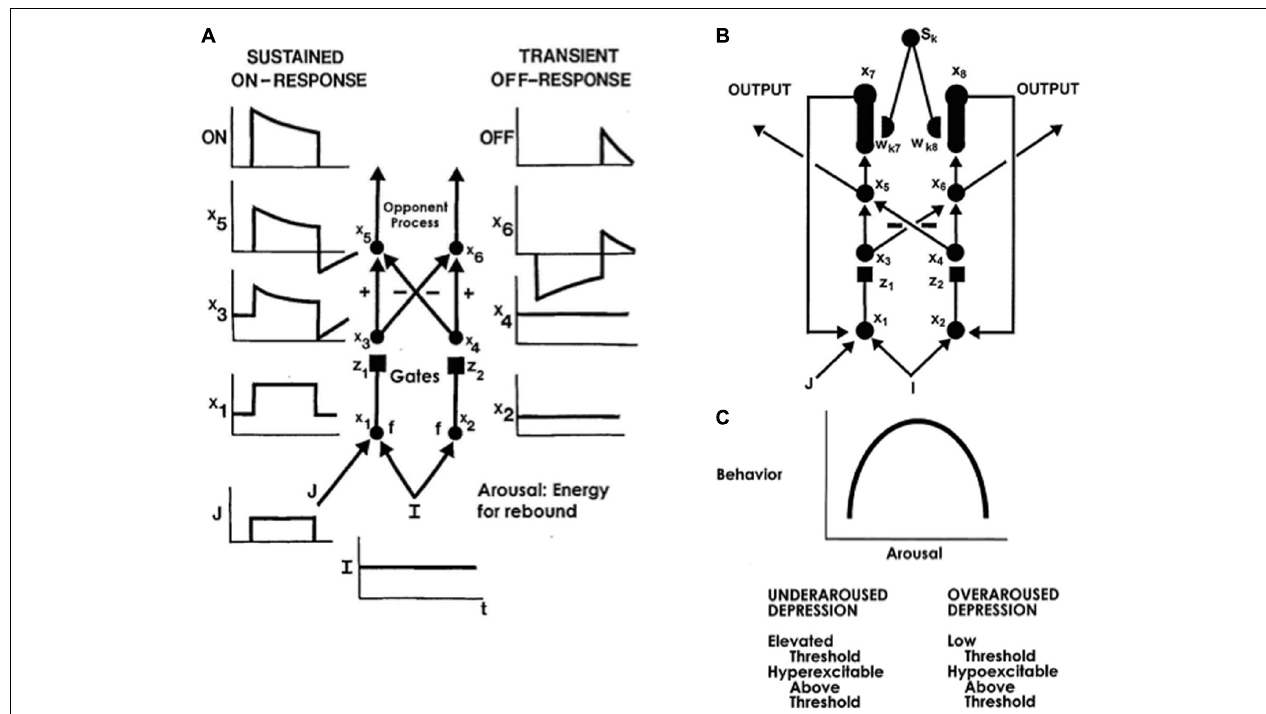
FIGURE 11 | (A) A gated dipole opponent process in a value category can generate habituative ON responses and transient OFF rebounds in response to phasic cue onset and offset, respectively. See text for details. (B) A READ (REcurrent Associative Dipole) circuit is a gated dipole with excitatory feedback, or recurrent, pathways between activities x 7 and x 1 , and activities x 8 and x 2 . Sensory representations S k send\conditionable signals to the READ circuit that are gated by conditioned reinforcer adaptive weights, or long-term memory (LTM) traces, w k 7 and w k 8 to the ON and OFF channels, respectively. Read-out of previously learned adaptive weights is dissociated from read-in of new values of the learned weights. This dissociation allows new weight learning to be generated by teaching signals from the ON or OFF channel that wins the opponent competition. The combination of recurrent feedback and associative dissociation enables the adaptive weights to avoid learning baseline noise, while they maintain in short-term memory the relative balance of ON and OFF channel conditioning during a motivated act, and preserve their learned conditioned reinforcer associations until they are disconfirmed by predictive mismatches if and when new learning contingencies are experienced. (C) When the tonic arousal level is chosen between low and high values, an Inverted-U in gated dipole responsiveness is caused. At low arousal levels, an underaroused depressive syndrome occurs. At overaroused arousal levels, an overaroused depressive syndrome occurs. See text for details. [Reprinted with permission from Grossberg and Schmajuk